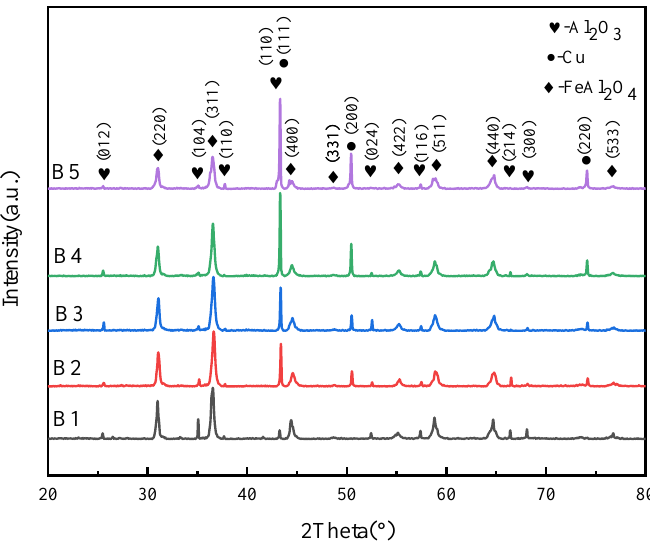
Figure 4. XRD patterns of composite coatings.